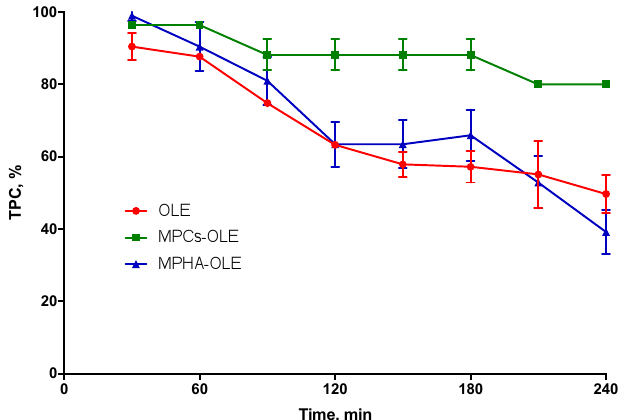
Figure 4. OLE stability in pseudo extracellular fluid (PECF) at 37 °C. Means ± SD ( n = 4).